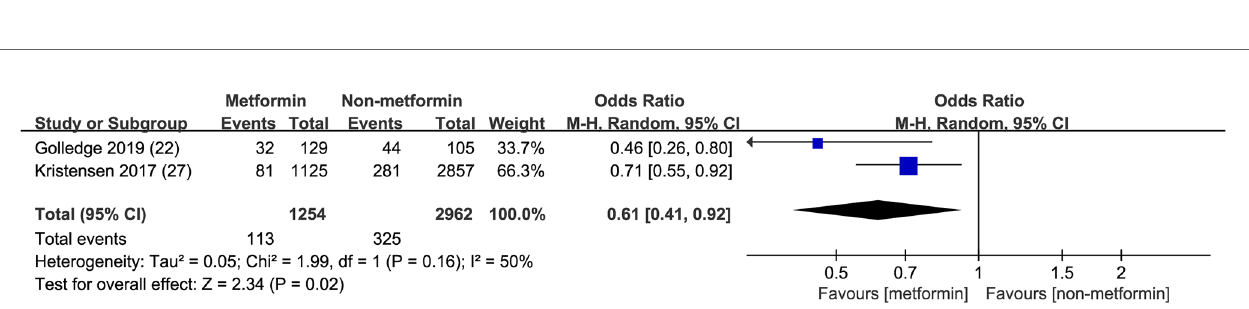
( Figure 8A ). As mentioned above, Itoga 2019 and Fujimura 2016 were excluded with reasons, and the funnel plot for the rest of studies was illustrated in Figure 8B . No publication bias was noted in the corrective study.